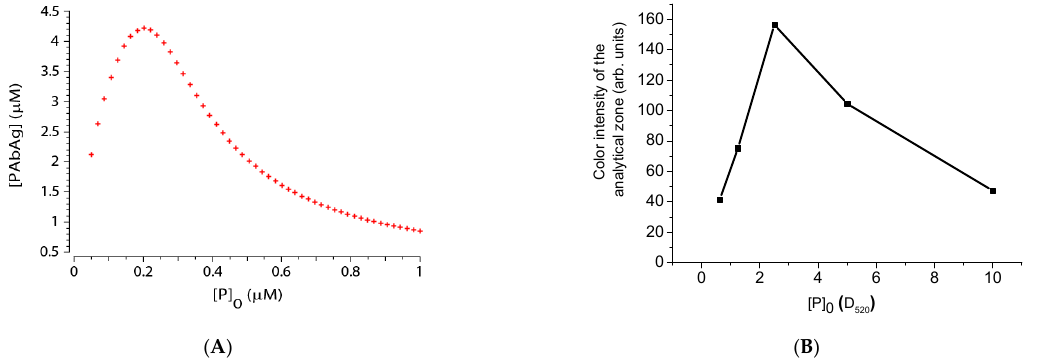
Figure 7. Dependences of analyte determination at different concentrations of labeled antigen ( A ) Theoretical dependence obtained by numerical simulation. Model parameters: T = 60 s; [P] 0 = 5 × 10 − 7 M; [Ag] 0 = 10 − 5 M; ka = 10 5 1/(M*s); kd = 2.5 × 10 − 3 1/s. ( B ). Experimental values of the color intensity (signal from the Reflekom analyzer) of analytical zones after the assay at different optical densities (D520) of the label conjugate.